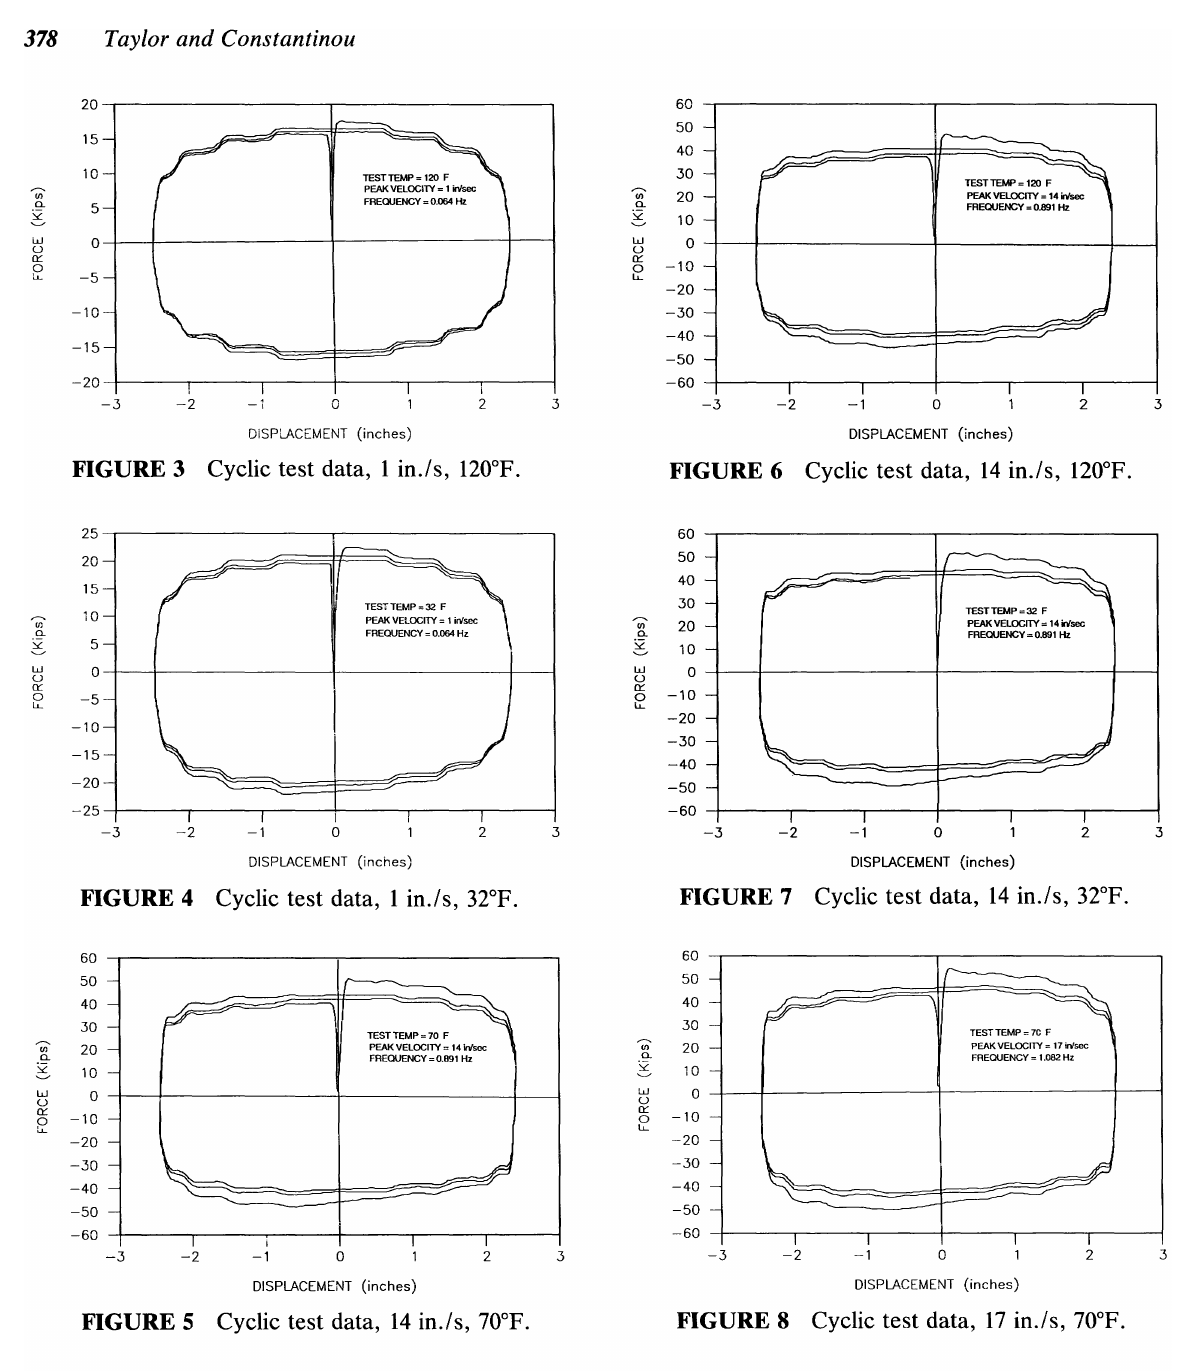
FIGURE 5 Cyclic test data, 14 in.ls, 70°F.